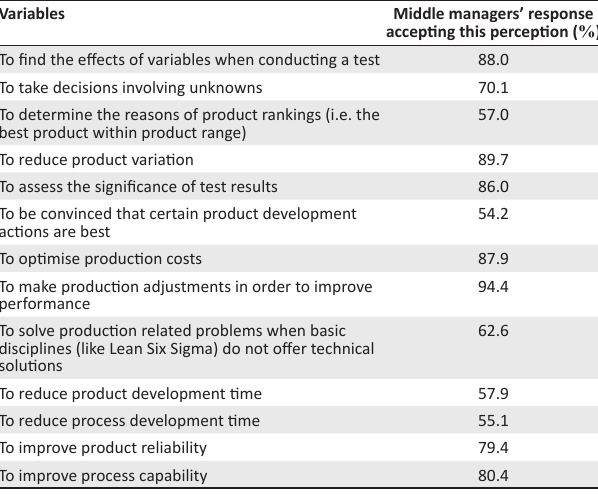
TABLE 2: Reasons for management to implement Design of Experiments.